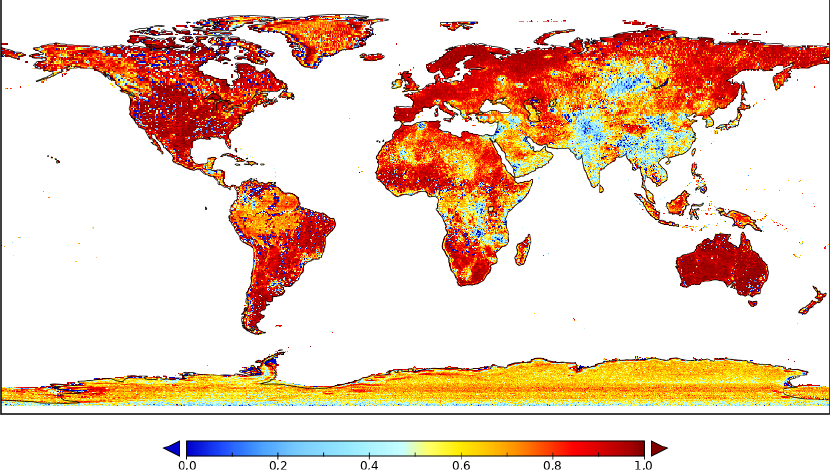
Figure 8. Map of the error correlation ( ρ 12 ) between SMOS nominal and SMOS NS (mean correlation: 0.71 and data gaps: 5.23%).